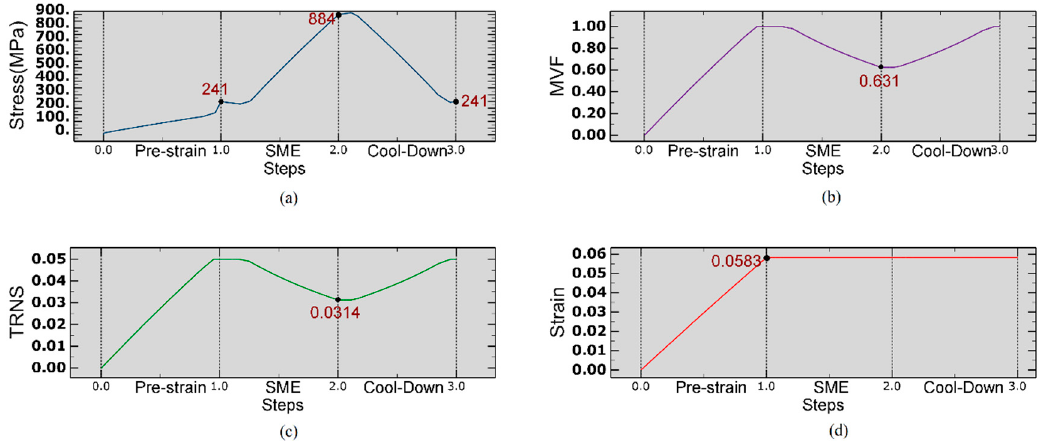
Figure 2. ( a ) Axial stress distribution under mechanical and thermal loads; ( b ) Evolution of Martensite Volume Fraction; ( c ) Induced axial Transformation Strain; ( d ) Total strain induced due to applied displacement.